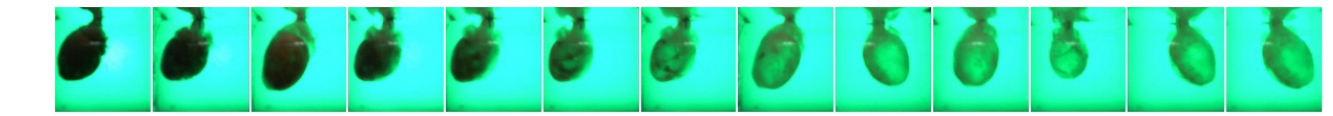
Figure 4. Application programming Interface. Once the process begins, the graphic of the live spectrometer metric can be seen on the upper right side. The progress bar below the camera stream is the classification metric (built with a Deep Convolutional Neural Network model) that shows the progress of the decellularization process (black arrow). The buttons below control the session and allow different commands such as starting, pausing, and ending. Resetting the position of the stepper motor to the initial phase is also possible. The weight of each rat heart is introduced in the program before starting the decellularization process.